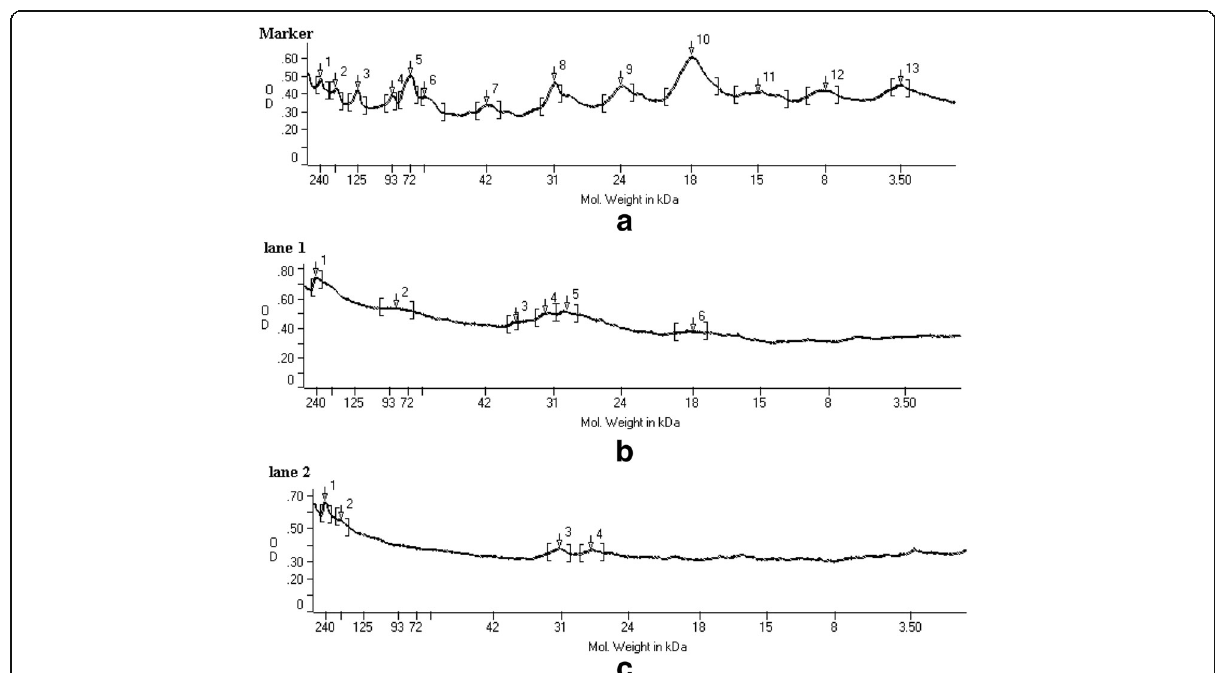
Fig. 3 Protein molecular weight and optical density of ( a ) marker, ( b) non-treated, and ( c ) Bacillus sphaericus -treated Culex pipiens